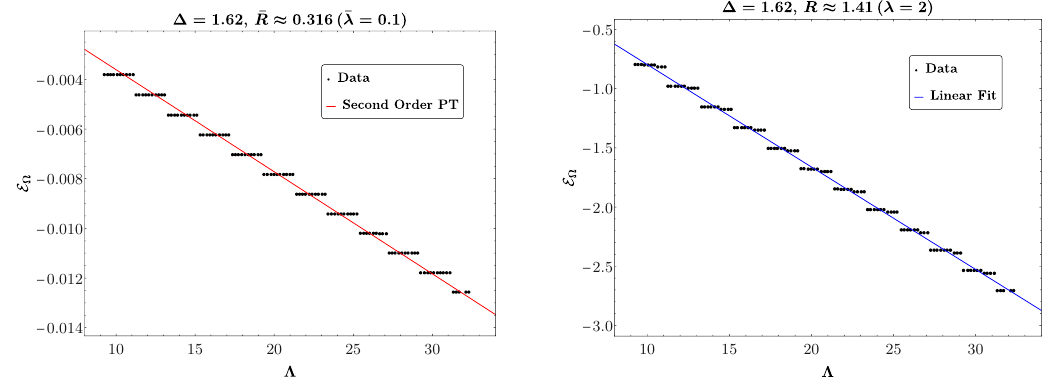
Figure 8. The vacuum energy linear growth in cutoff. The left plot shows the agreement of the data with second order perturbation theory. The right plot shows the linear growth beyond perturbation theory ( ¯ λ = 2 ). ¯ R is the radius of AdS in units of the coupling, as defined in eq. (2.24).